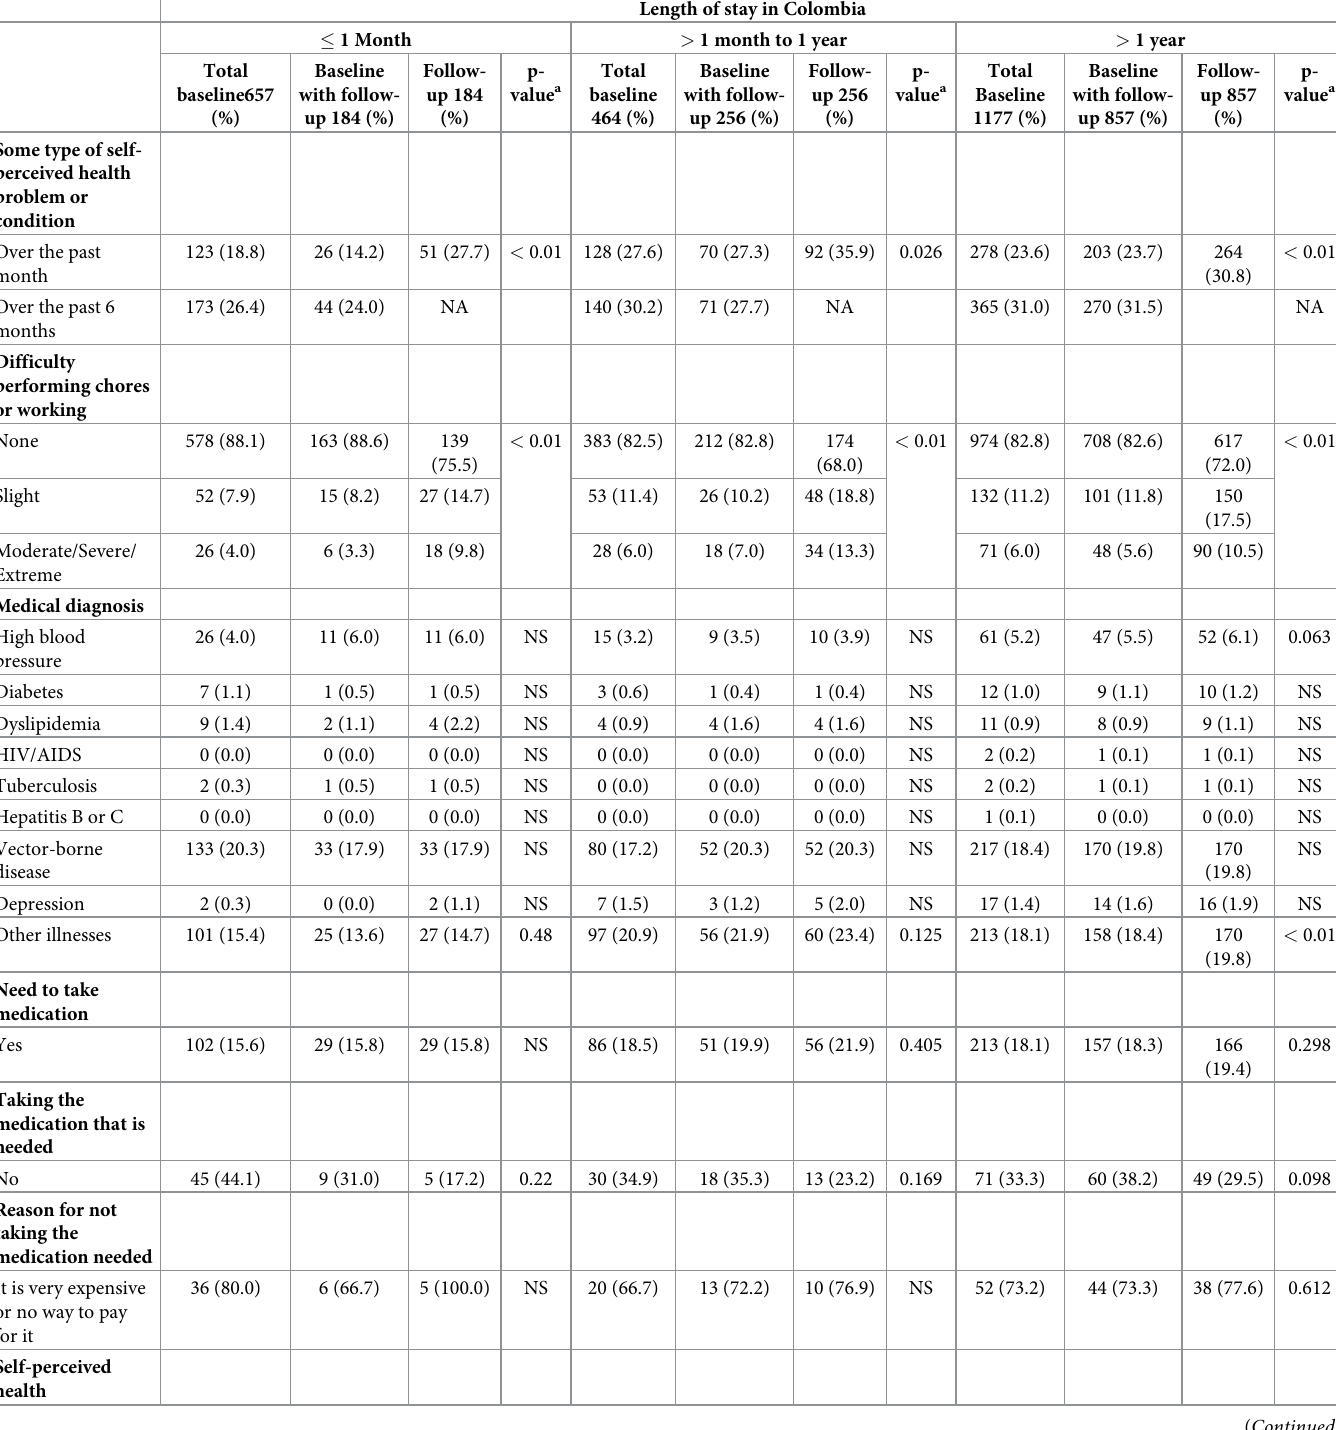
Table 3. Health characteristics, self-perceived morbidity and food security by length of stay in Colombia, among the migrant women with irregular migratory sta- tus participating in ELSA-VENCOL,